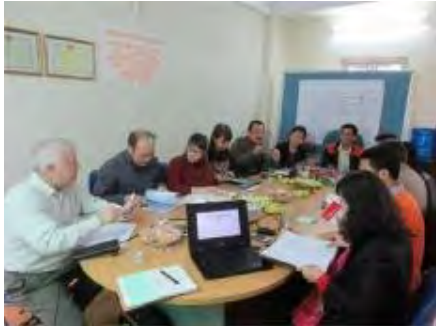
Figure 4. Ameeting among the working group of public, private and non-profit sectors fordiscussions on establishing a PPP coordinating committee for